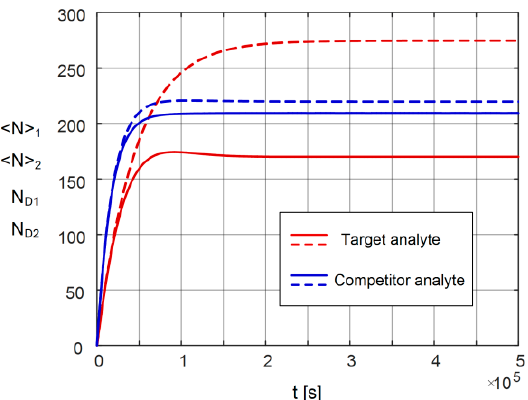
Figure 2. Time evolution of the expected value of the adsorbed particles numbers of two analytes, obtained by using the stochastic model of sensor response (solid lines), and the time dependence of the numbers of adsorbed particles according to the deterministic model of sensor response (dashed